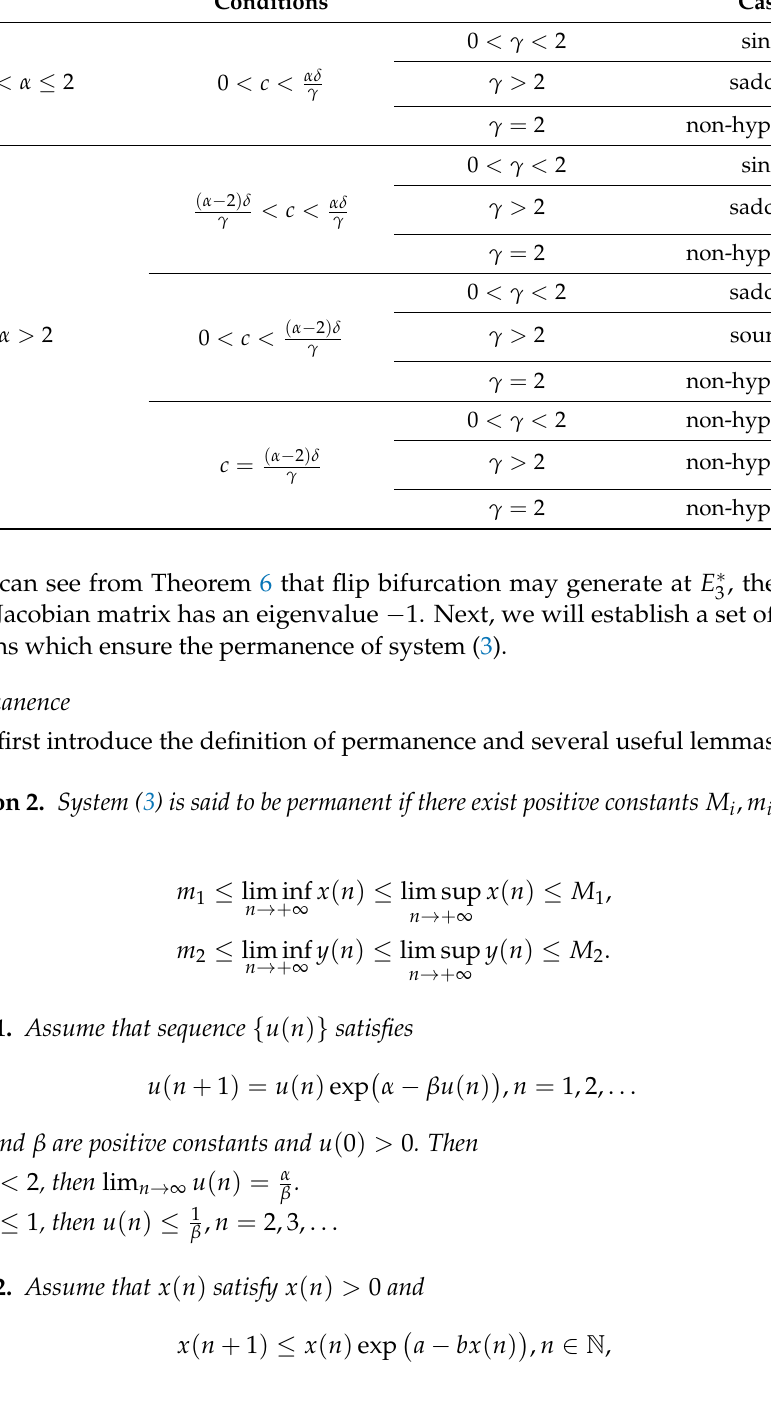
Table 1. Topological types of the fixed point E ∗